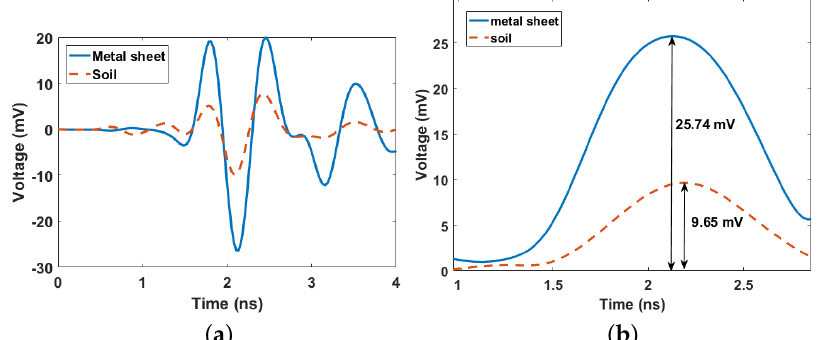
Figure 5. ( a ) Measured reflected pulses from the air-soil and air-metal interfaces without time-offset correction. Both pulses can be seen to arrive between 1.4–2.6 ns; ( b ) Envelope of the Hilbert transform of both